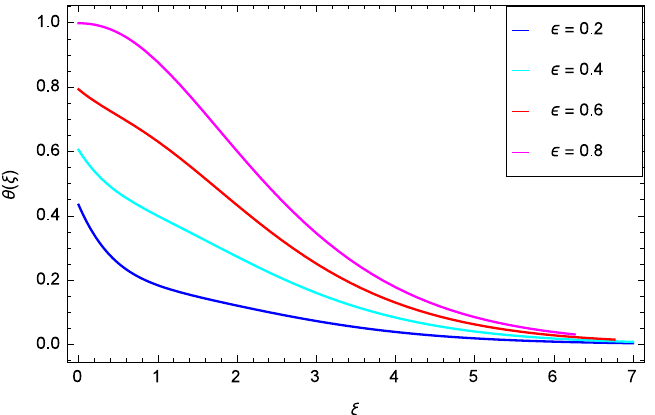
Figure 13. Impact of the curie temperature parameter ε on temperature θ ( ζ ) .